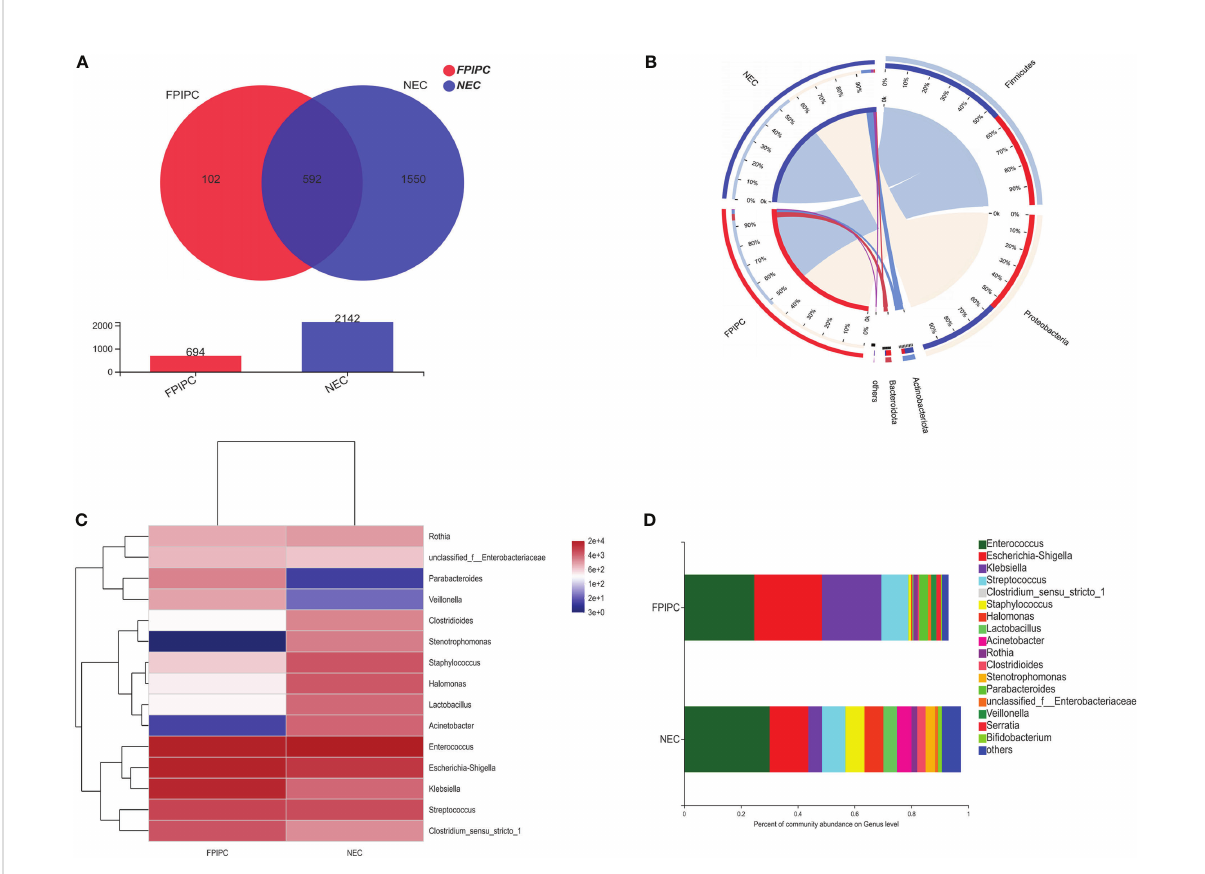
FIGURE 2 Shared and unique microbiota between the necrotizing enterocolitis (NEC) and food protein-induced allergic protocolitis (FPIAP) groups. (A) The Circos plot shows each main phyla between the NEC and FPIAP groups. Outer bars show the percentage of reads in a category that are connected to the category at the other end of the drawn band. (B) The heatmap displays genus-level changes (rows) between the samples of NEC and FPIAP groups (columns). The variation of each genus is indicated by a gradient of color from blue (decease) to red (increase). (C) Genus-level taxonomic composition of the NEC and FPIAP infants. Relative abundances are reported on the horizontal axis and the two groups on the vertical axis (D)